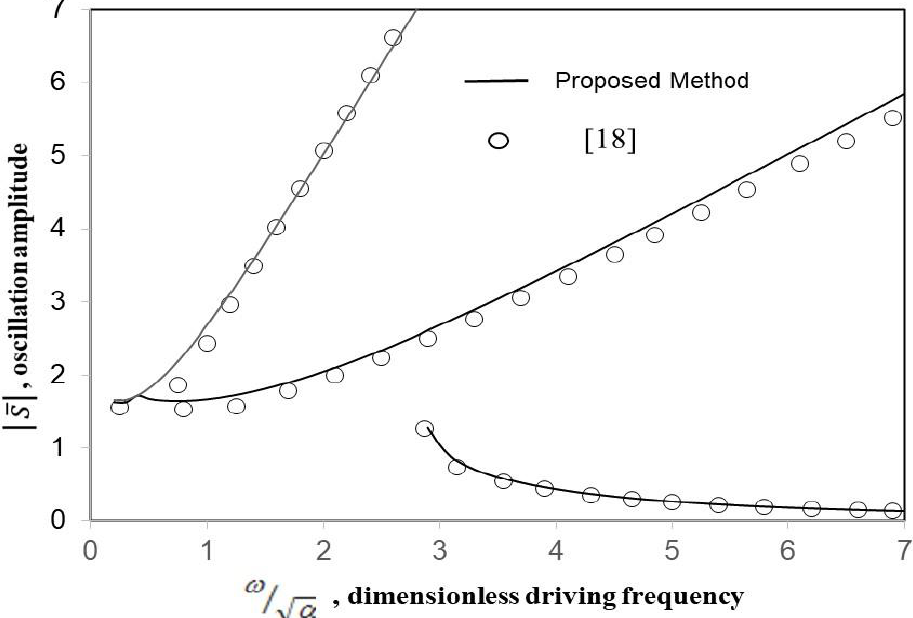
Figure 2. Comparison between the frequency response curves obtained from the proposed method and [18] ( α = 1, β = 2, Γ = 6). Table 1. Vibration amplitude convergence for various driving frequencies and number of modes used ( c/a = 0.5, k = 10, ξ = 0).